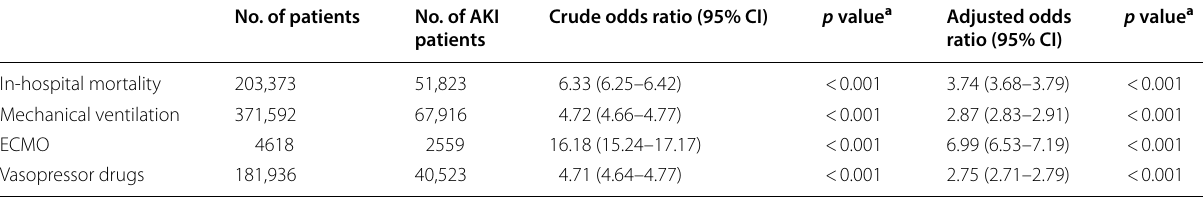
Adjusted for age, gender, tertiary hospital, year, Charlson index, myocardial infarction, congestive heart failure, cerebrovascular disease, rheumatologic disease, peptic ulcer disease, liver disease, diabetes, renal disease, cancer, AIDS/HIV, and organ dysfunction (respiratory, cardiovascular, hepatic, hematologic, neurologic) AIDS acquired immune deficiency syndrome, AKI acute kidney injury, CI confidence interval, ECMO extracorporeal membrane oxygenation, HIV human immunodeficiency virus a Mixed effects logistic regression